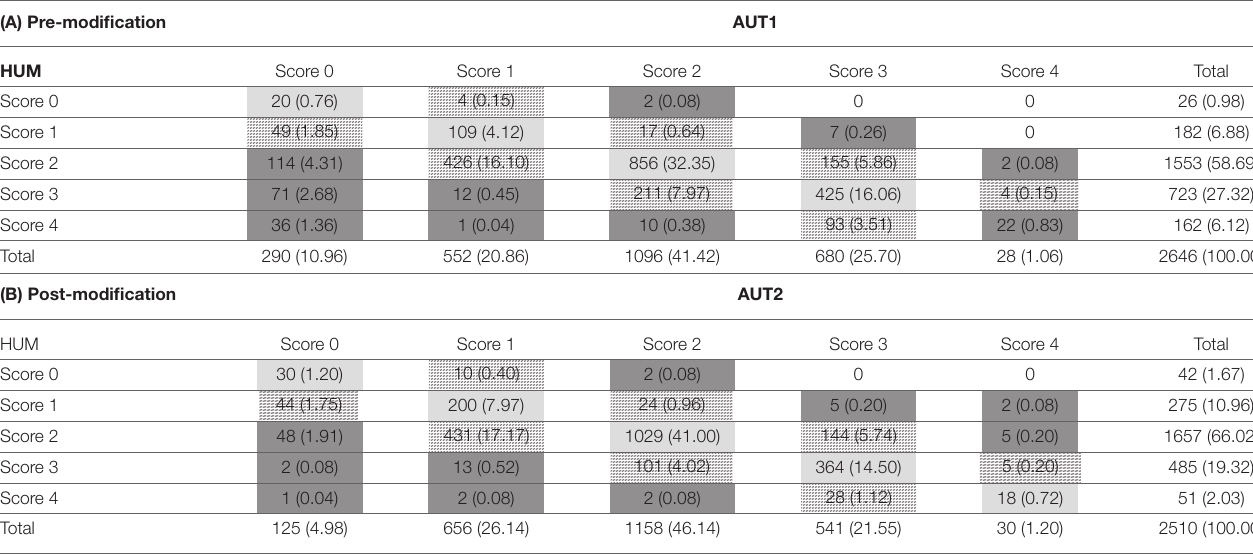
TABLE 3 | Measures of agreement/disagreement between scoring methods. (A): Pre-modification, (B): Post-modification. (A) Pre-modification